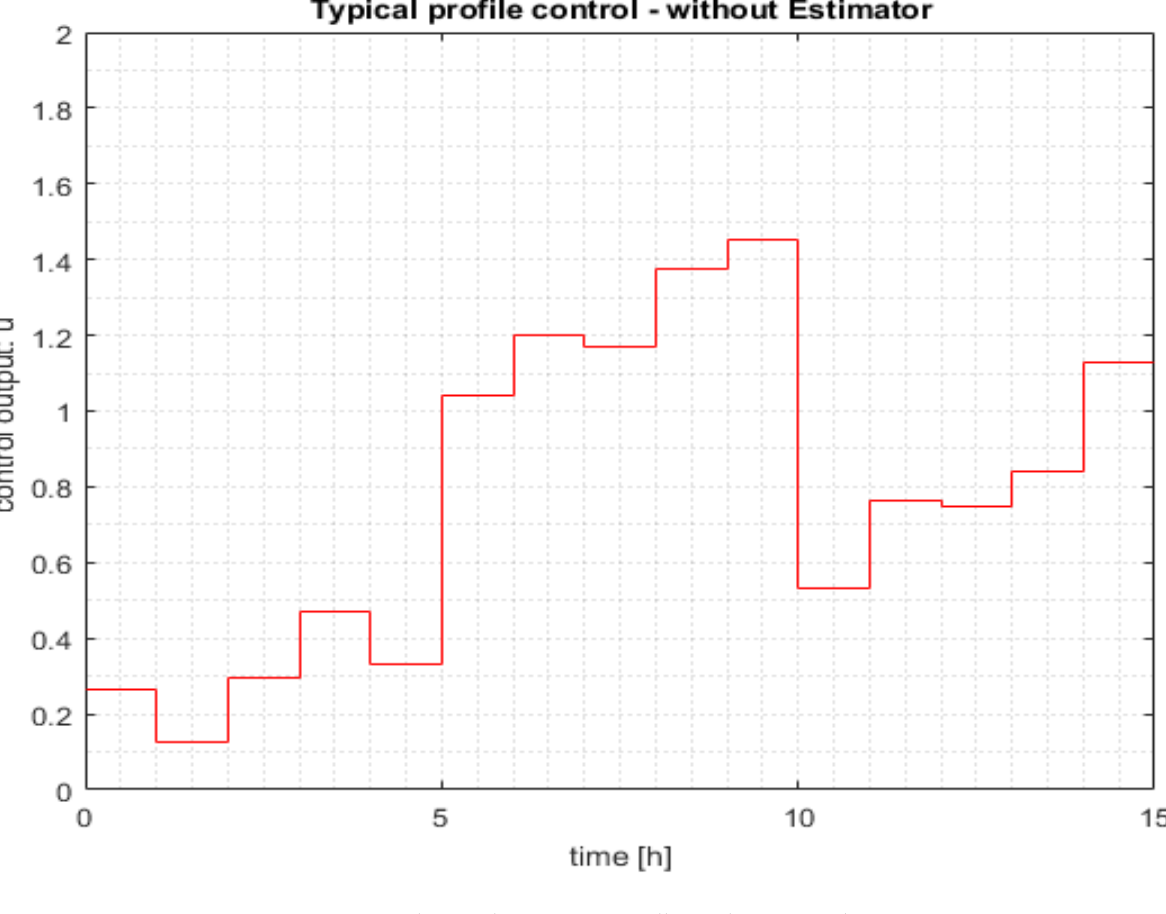
The control outputs of uRHC sent to the Process involve the typical state evolution